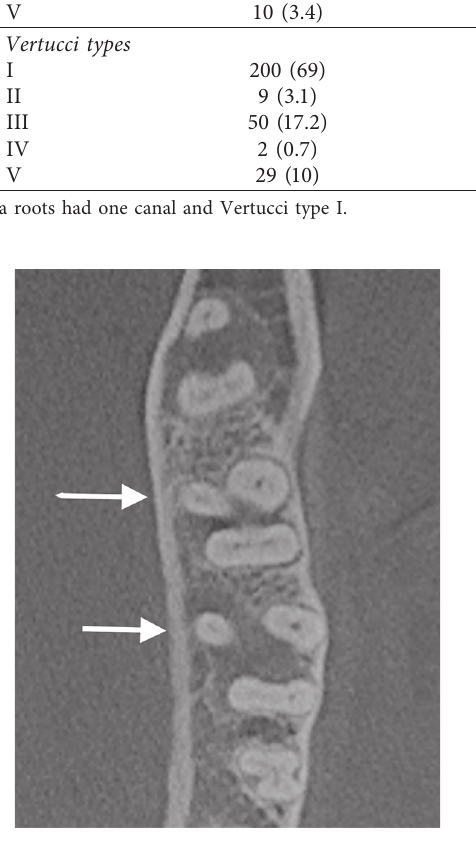
Figure 1: CBCT axial section at midroots of first and second mandibular molars showing the presence of a third root